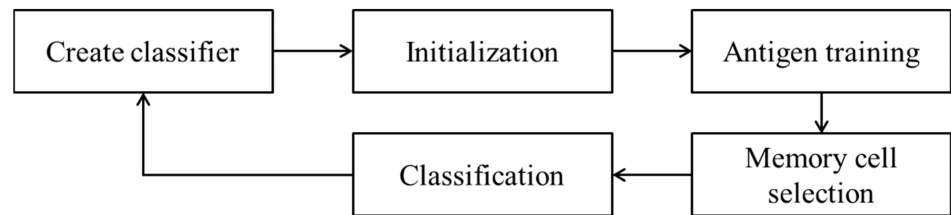
Figure 1. Overview of the artificial immune system (AIS) algorithm.